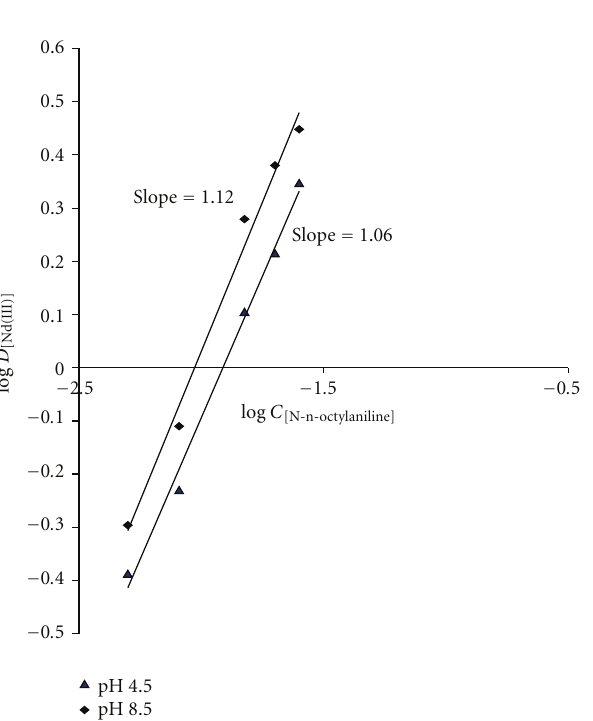
Figure 4: Log-log plot of log D [Nd(III)] versus log C [N − n − octylaniline] at 0.06M sodium salicylate with pH 4.5 and pH